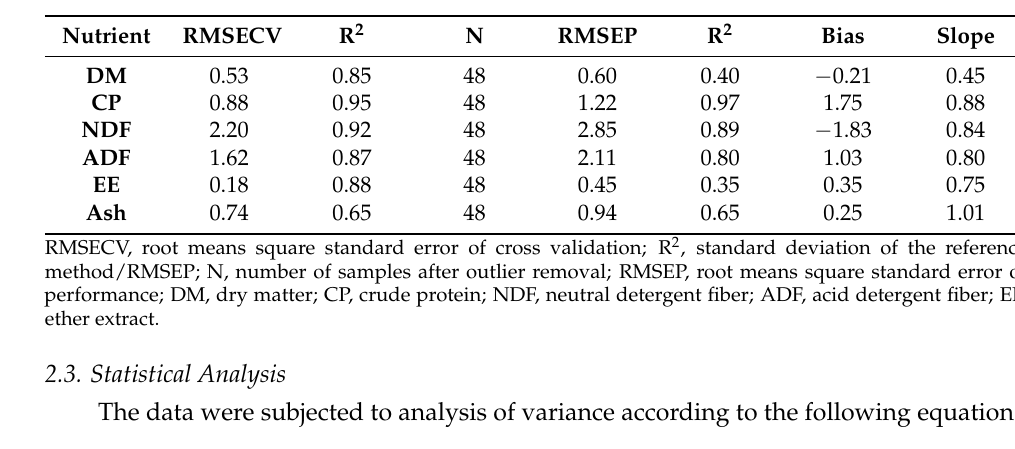
Table 2. NIRS calibration parameters or validations of the method used for forages analysis.